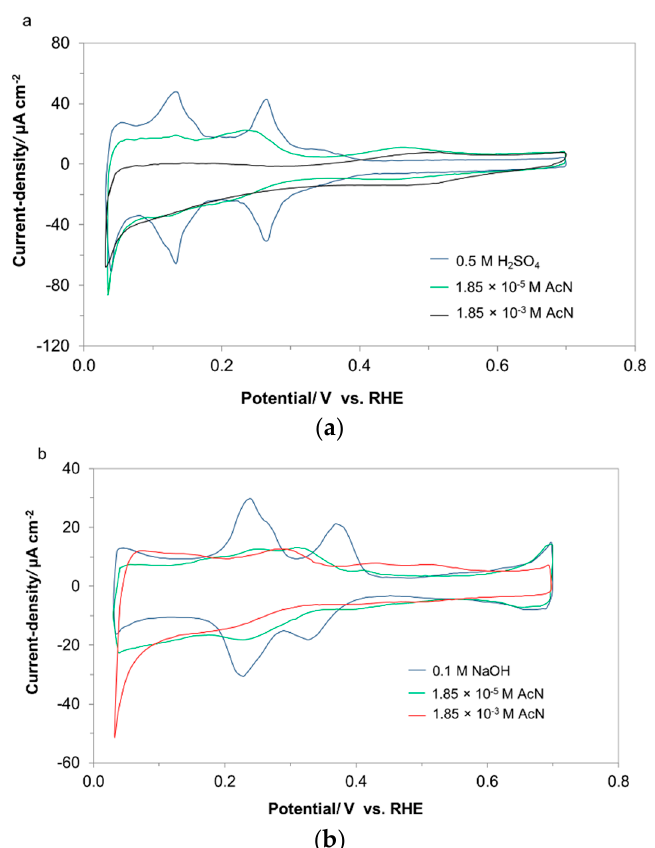
Figure 1. ( a ) Cyclic voltammograms for polycrystalline Pt electrode in 0.5 M H 2 SO 4 at a sweep-rate of 0.050 V·s − 1 (at 293 K) and in the presence of AcN at the concentrations indicated; voltammograms were recorded on the second cycle and ( b ) as above, but recorded for Pt polyoriented single-crystal sphere electrode in 0.1 M NaOH.